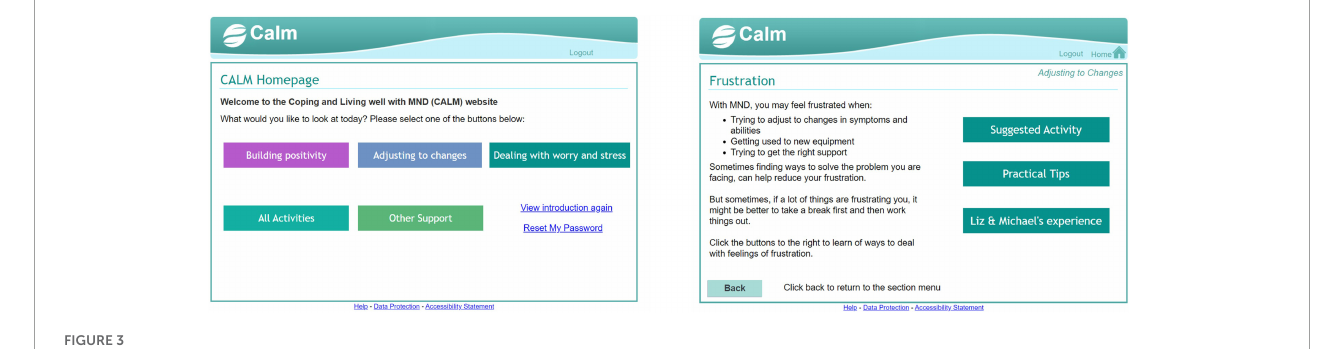
FIGURE3 Example 1 of pages from the CALM website.